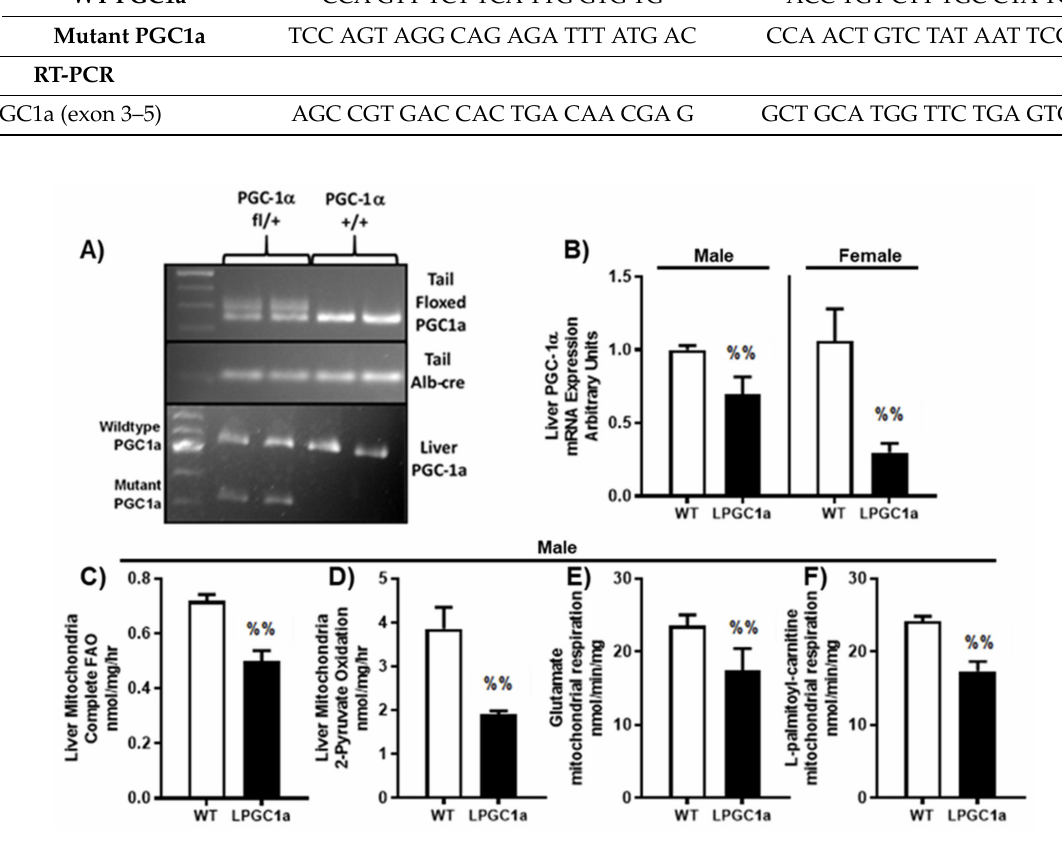
Figure 1. Liver-specific PGC1a heterozygosity results in reduced fatty acid oxidation and oxidative capacity in isolated liver mitochondria. ( A ) Tail and liver genotyping of WT and LPCG1a mice. ( B ) Relative liver mRNA expression of PGC1a. Complete oxidation of 1-[14C]-palmitate ( C ) and 2-[14C]-pyruvate ( D ) to CO 2 in isolated liver mitochondria in male mice. Isolated liver mitochondrial respiratory capacity was determined in male mice by the measurement of O 2 consumption using a Clark electrode system in the presence of ( E ) glutamate (+malate) and ( F ) L-palmitoyl-carnitine (+malate) during state 3 respiration (+ADP). Values are means ± SEM ( n = 4–6). %% p < 0.05 WT vs. LPGC1a for t